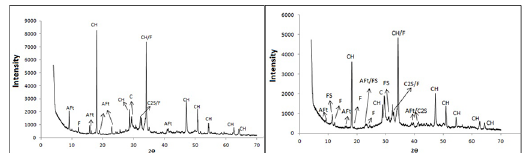
Figure 9. X-ray diffraction patterns for the reference and 20% samples. CH (Ca(OH) FS (Friedel`s